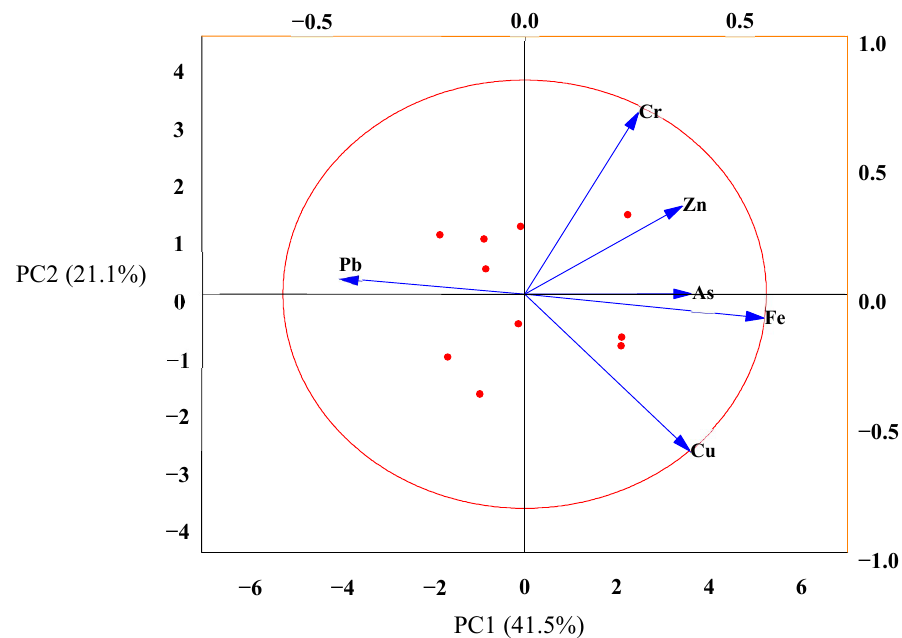
Figure 4. Heavy metals pollution source identification by PCA in the soil samples.